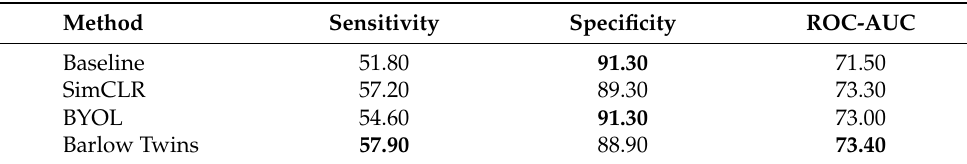
Table 1. Caries classification results when fine-tuning on the full training set. We highlight in bold the best